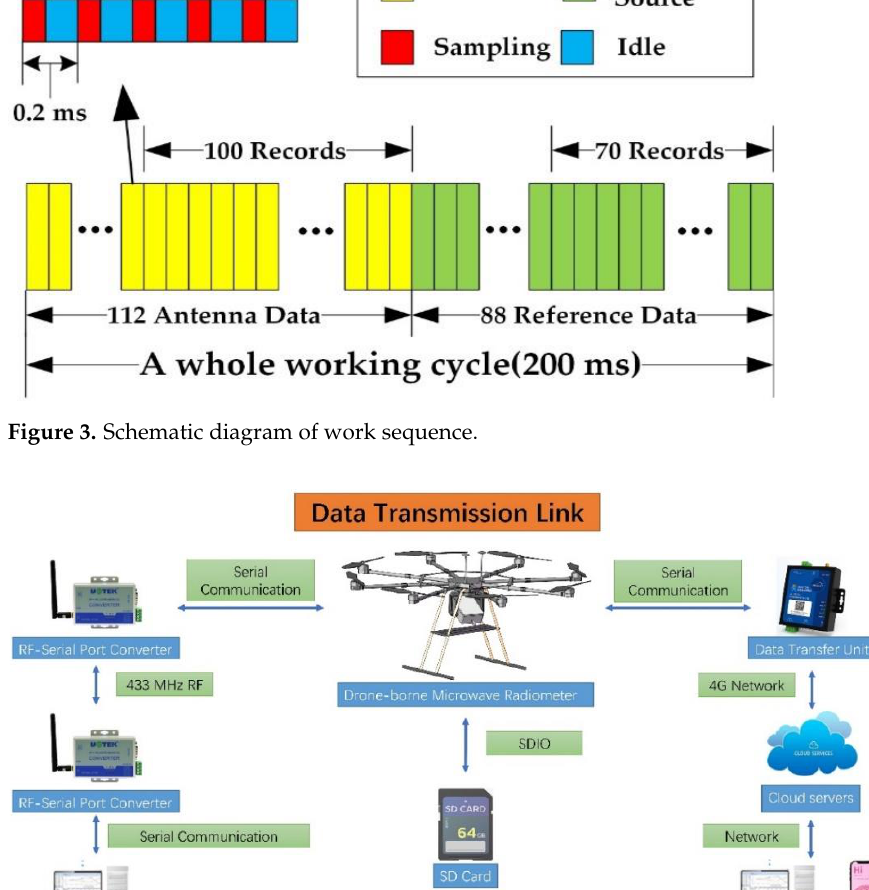
Figure 3. Schematic diagram of work sequence.